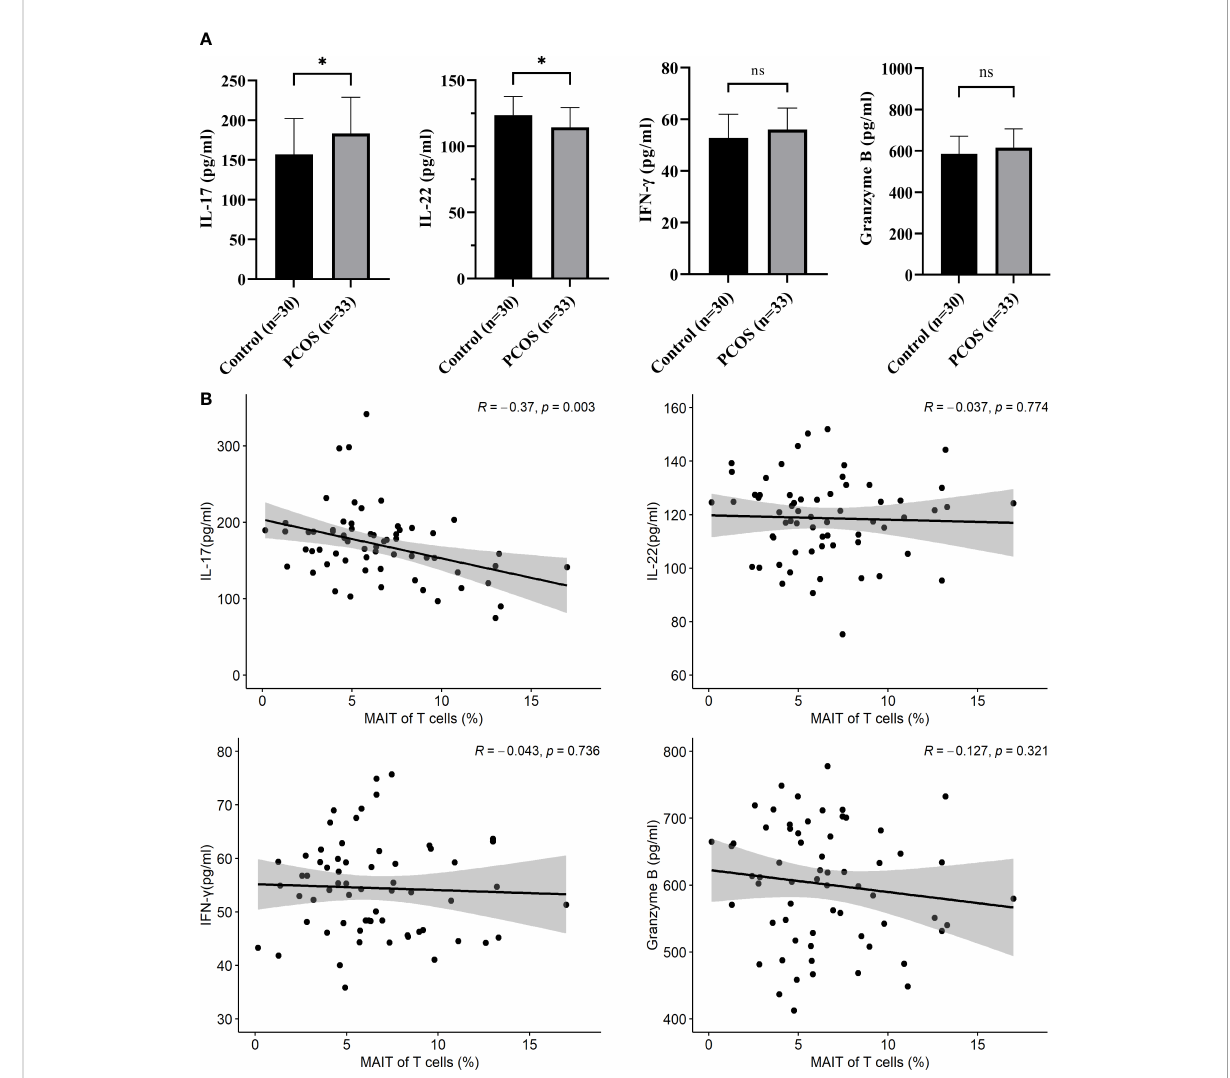
FIGURE 5 Cytokines in the plasma of control and PCOS patients. (A) compared L-17, IL-22, IFN- g and granzyme B between control and PCOS patients. (B) The Pearson Correlation between the frequency of MAIT cells and cytokines in plasma. *p<0.05, ns, not signi fi